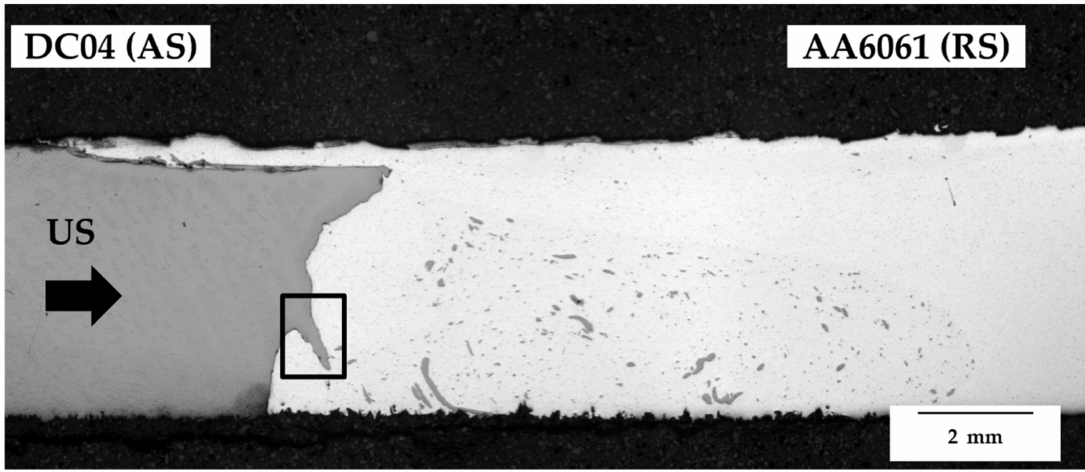
Figure 6. Cross section image of an ultrasound enhancement (USE-FSW) AA6061 / DC04 joint with ultrasound transmission into